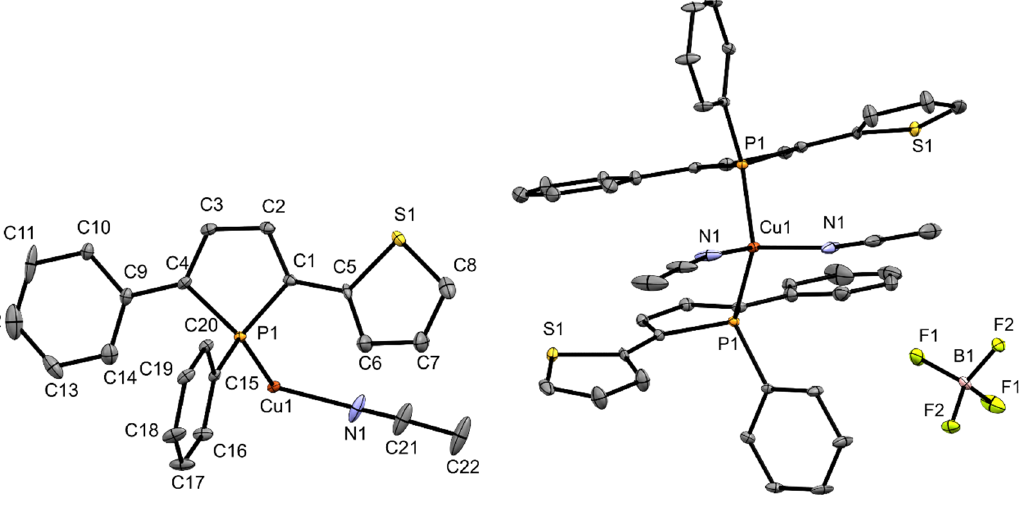
Figure 2. Ortep plots of the molecular structure of 3 in the solid state with ellipsoids drawn at the 30% probability level. Labels for some selected atoms, disorders and hydrogen atoms are omitted for clarity. Important bond lengths and angles: (C4)–(C9) 1.448(7) Å, (C1)–(C5) 1.464(7) Å, (C1)–(C2) 1.346(7) Å, (C2)–(C3) 1.440(7) Å, (C3)–(C4) 1.354(7) Å, (P1)–(C4) 1.816(5) Å, (P1)–(C1) 1.812(5) Å,